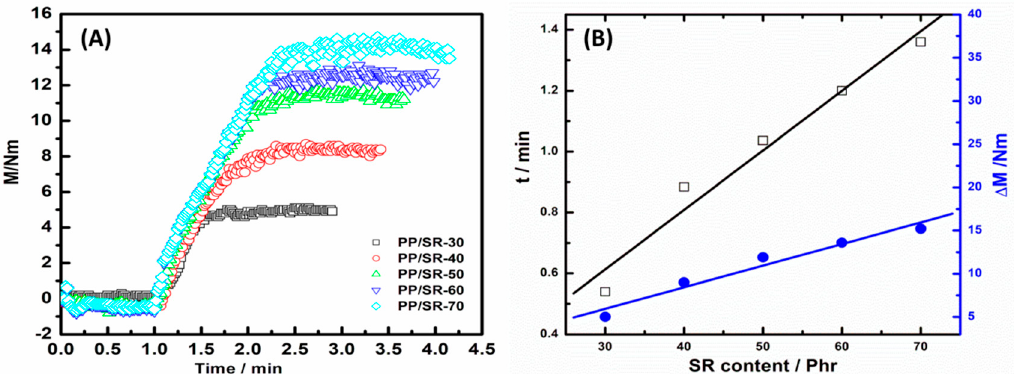
Figure 1. ( A ) Mixing torque change of polypropylene (PP)/silicone rubber (SR) blends in dynamic vulcanization process and ( B ) the relationship between SR content and torque change ( Δ M ) and dynamic vulcanization time ( t ).